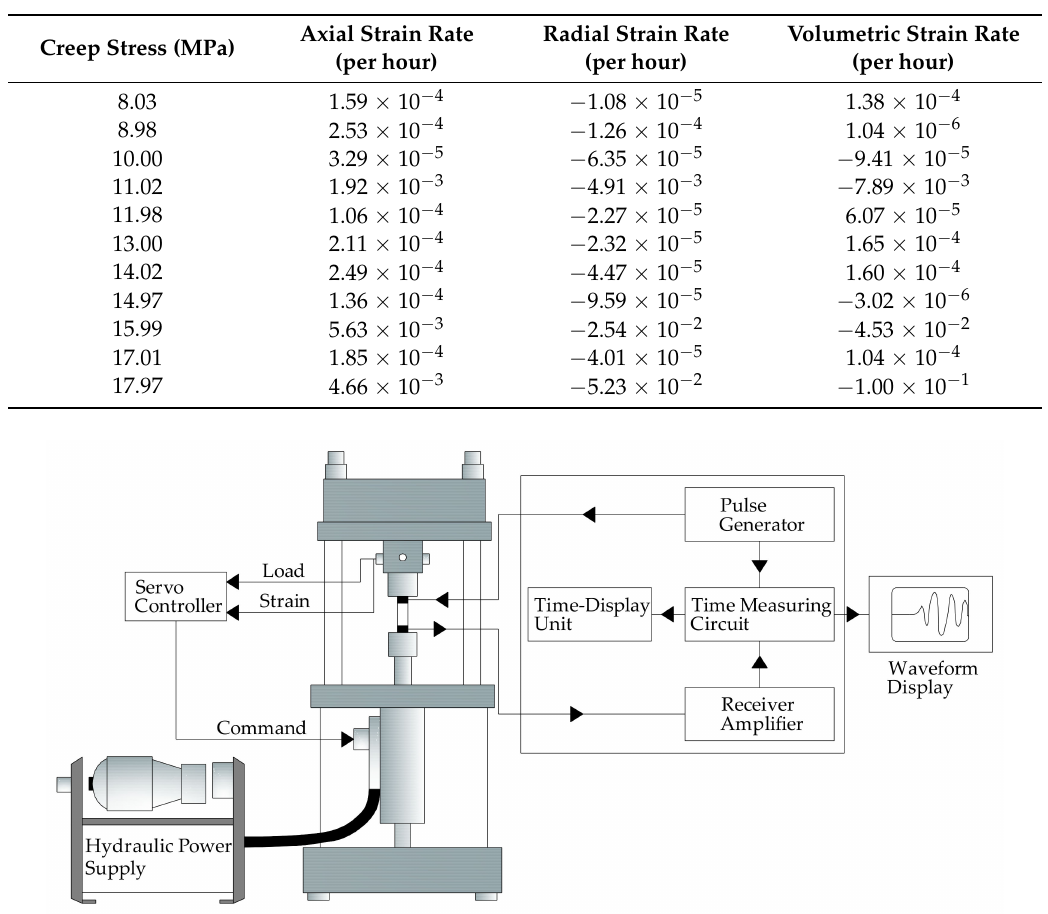
Figure 3. Schematic diagram for the equipment